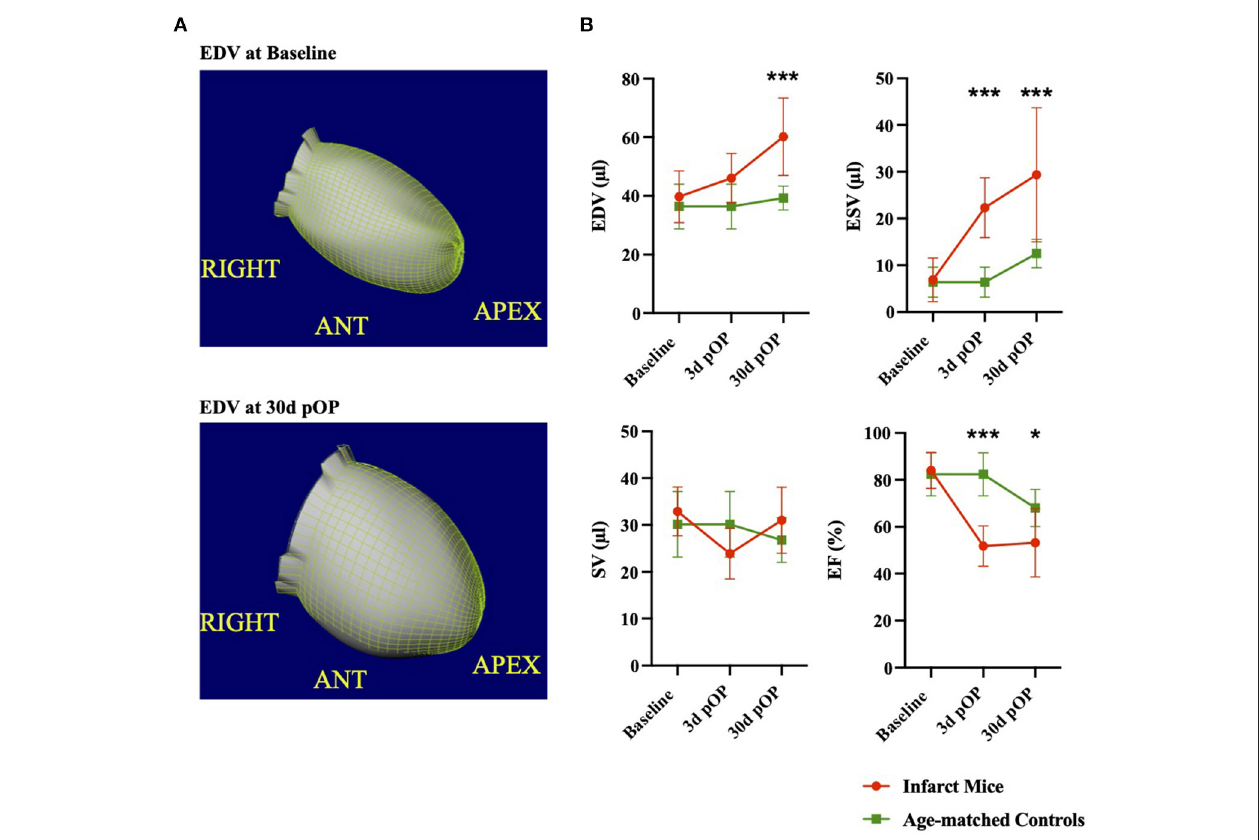
FIGURE 4 | Evaluation of cardiac function after myocardial injury in comparison to age-matched littermates (A) illustrates three-dimensional reconstruction of the left ventricular EDV in the ROA view. Upper picture: EDV at baseline and lower picture at 30 days post-LAD ligation. (B) Comparison of cardiac PET parameters at baseline, 3, and 30 days post-MI. Data of healthy age-matched littermates are illustrated in green, and infarct mice are in red. All groups: n = 6-16. Data represent mean ± SD. * p < 0.05, ** p < 0.01, *** p <